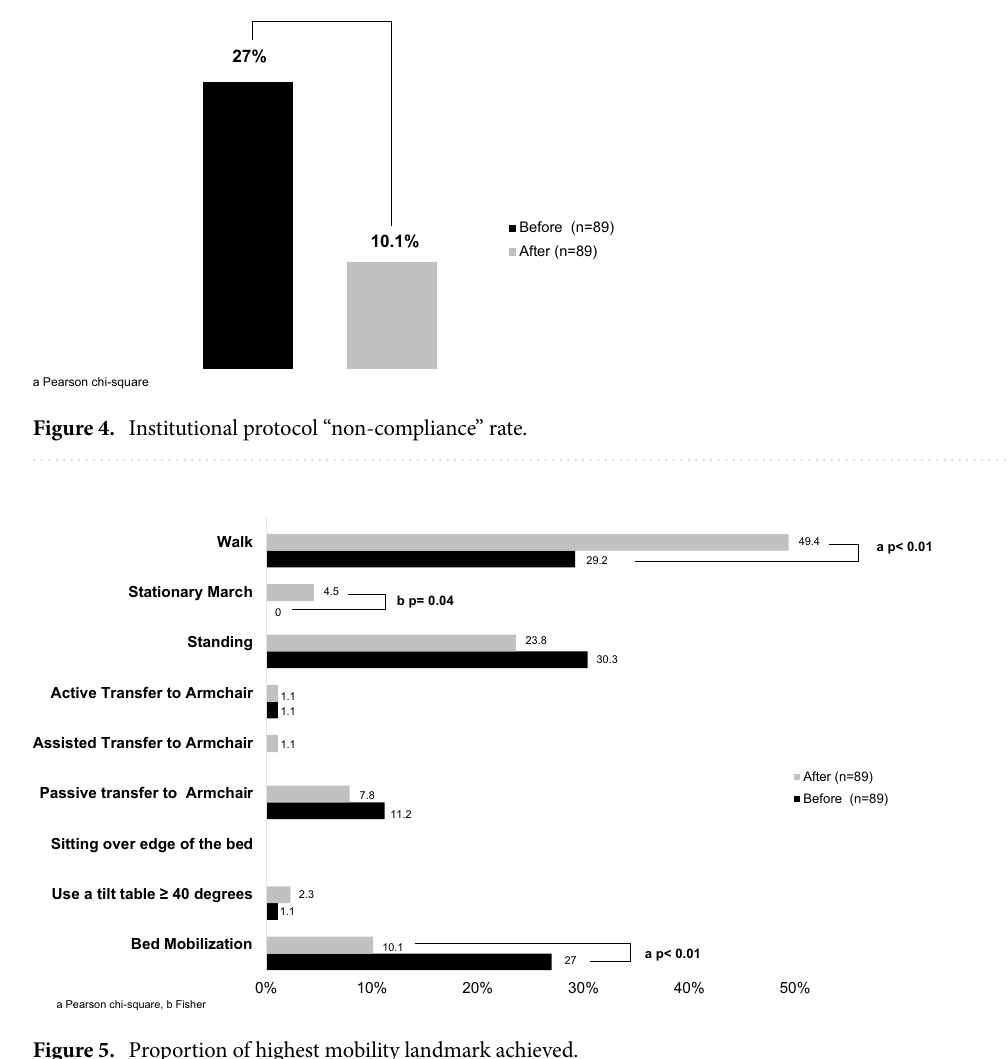
Before (89 patients) After (89